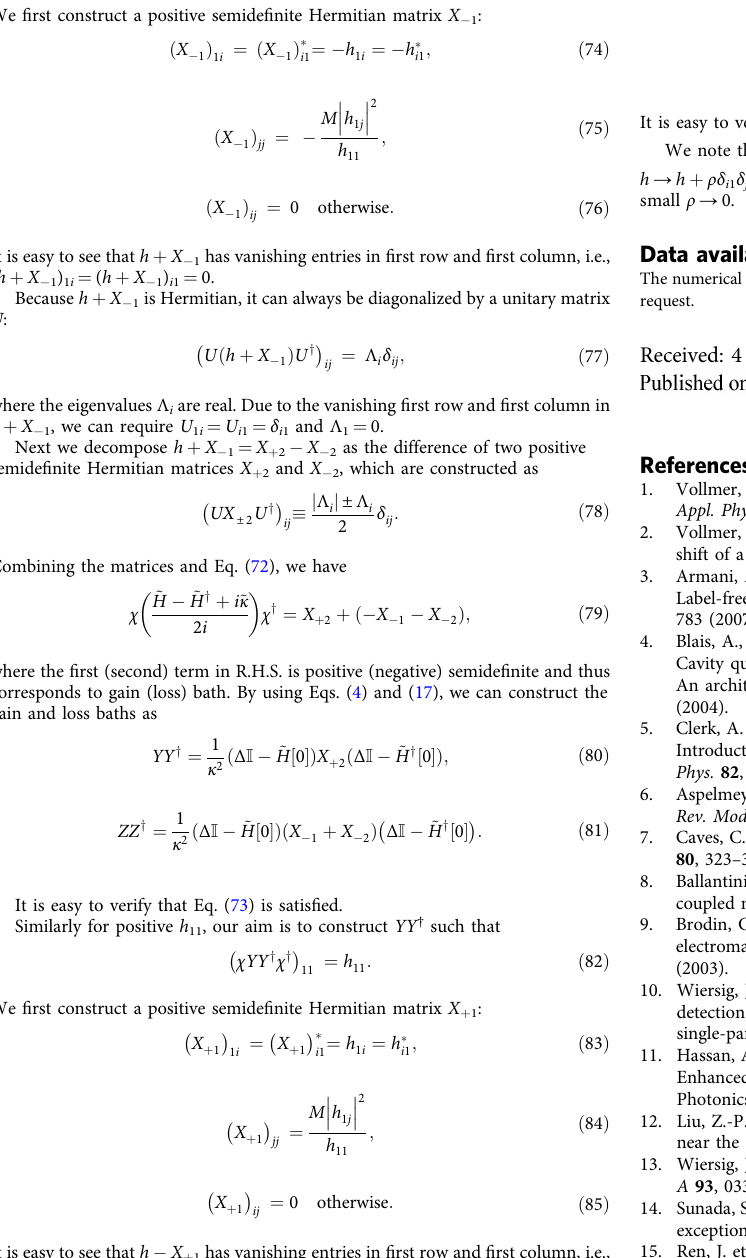
15. Ren, J. et al. Ultrasensitive micro-scale parity-time-symmetric ring laser gyroscope. Opt. Lett. 42 , 1556 – 1559